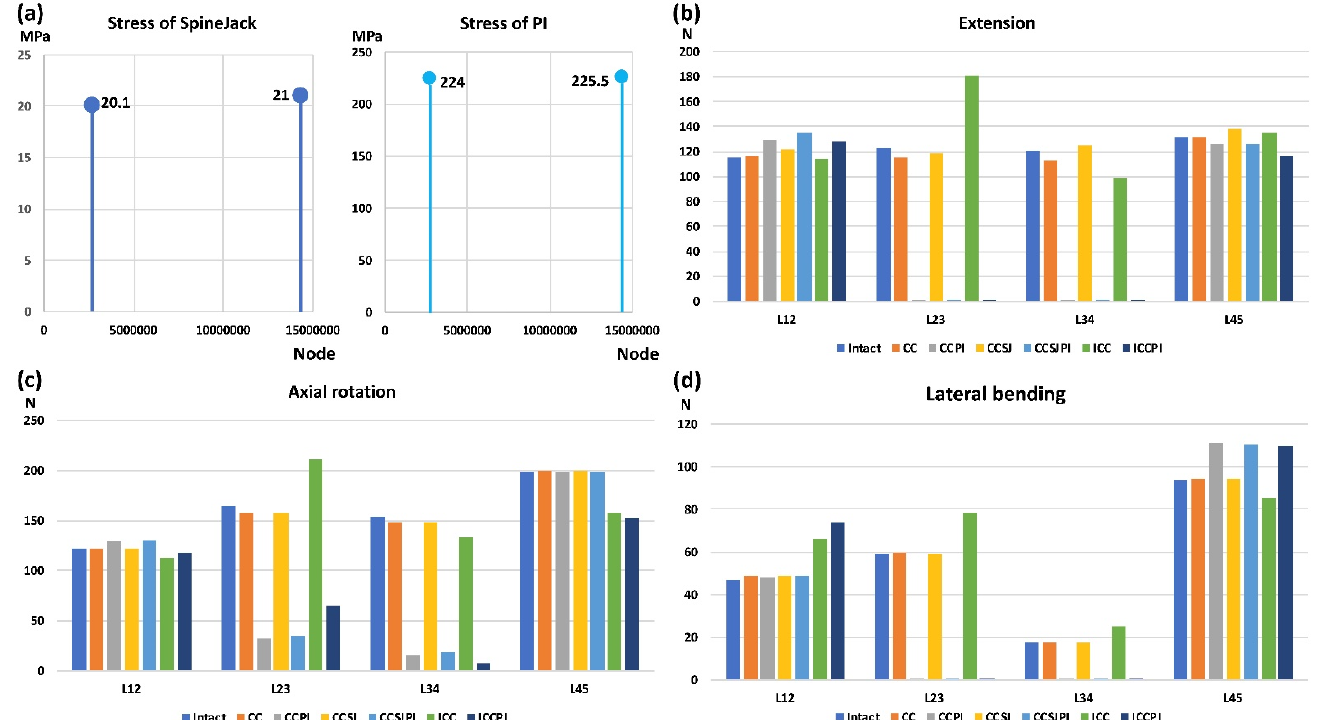
Figure 4. The results of validation of total ROMs, facet joint force and peak disk stress (median, maximum, and minimum of the four disks), and normalized ROM with bone cement and SpineJack .